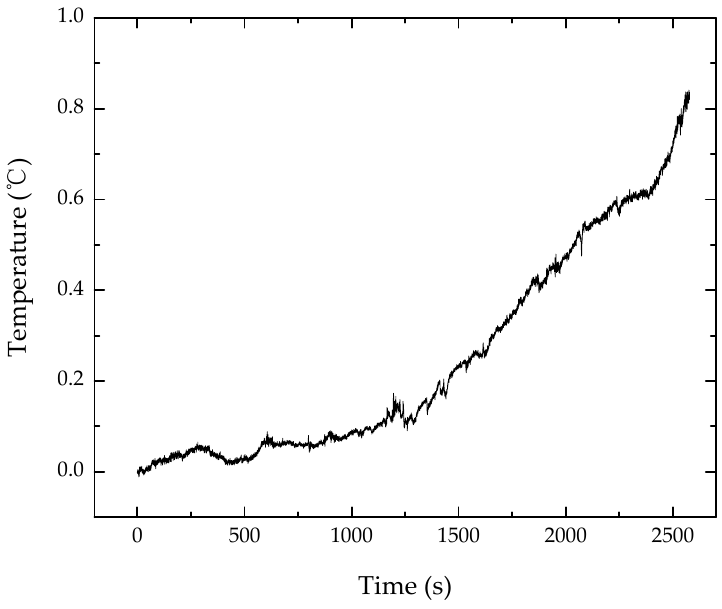
Figure 13. Temperature during the ground test recorded by FBG sensors.